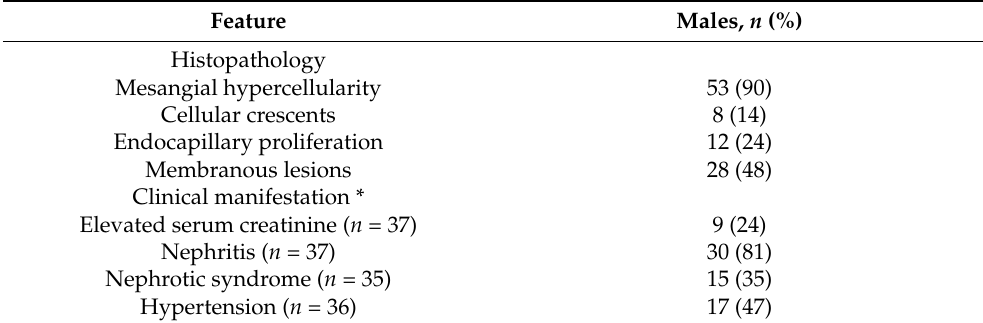
Table 3. Histopathology and clinical manifestations of kidney injury at time of diagnosis in n = 59 males with lupus